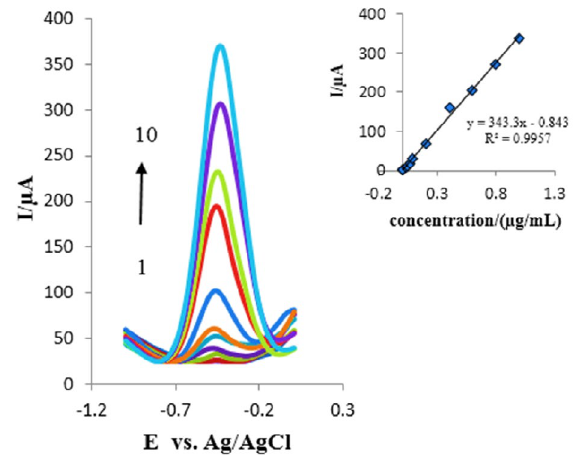
Fig. 4. DPVs at Ni Zn Fe O /CPE in PBS (pH 3.0) containing different concentrations of Mo (VI) (from 1 to 0.5 0.5 2 4 10, the concentrations: 0.008, 0.03, 0.05, 0.07, 0.09, 0.2, 0.4, 0.6, 0.8, 1.0 µg mL -1 of Mo (VI)) under the optimized conditions. Inset: Plot of the oxidation peak currents as a function of Mo (VI)